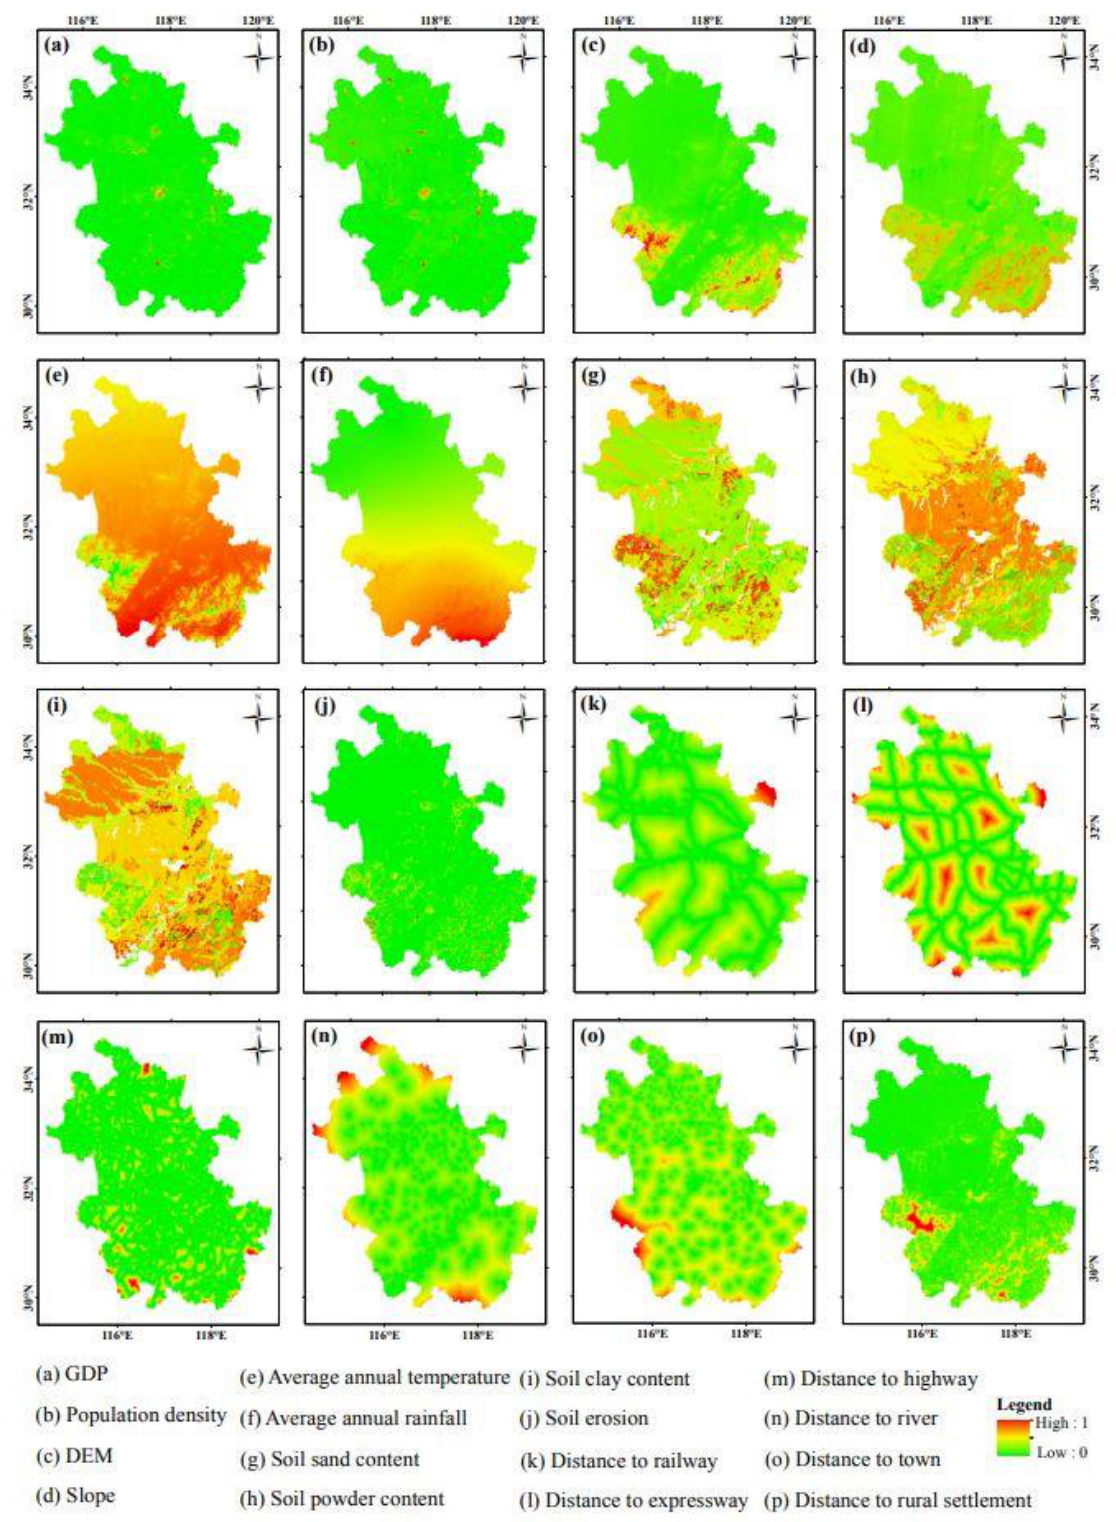
Figure 4. Raster map of land use change driving factors for the FLUS model. Table 5. ROC values of the logistic regression model.